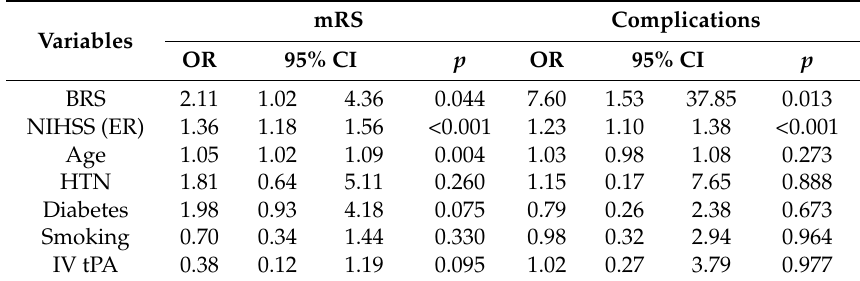
Table 4. Multiple logistic regression for dependence 1 month after stroke and complications during